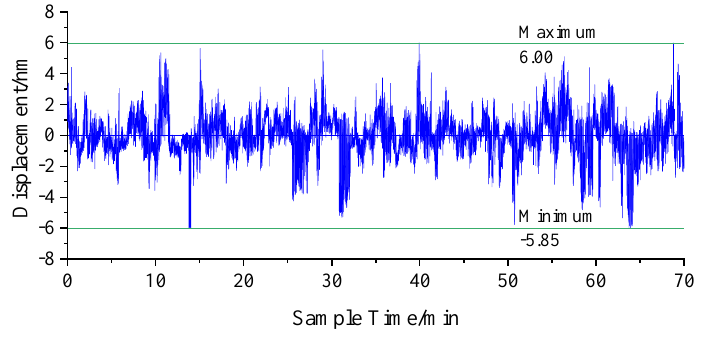
Figure 20. Stability test results.